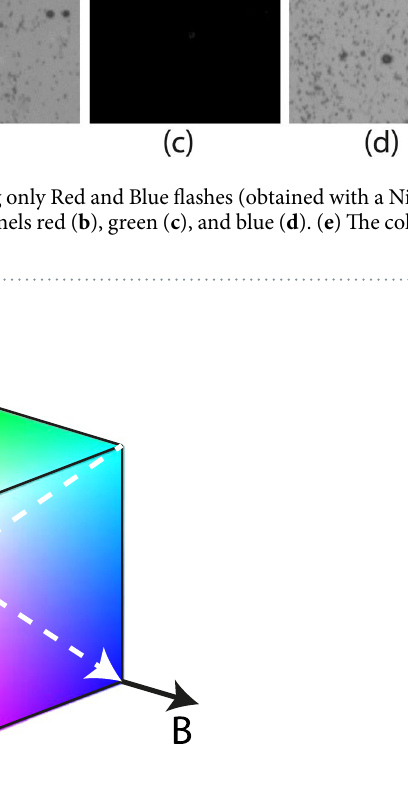
Figure 5. The RGB color space represented in Cartesian coordinates. The white dashed arrows link the corresponding negative colors that are captured in the